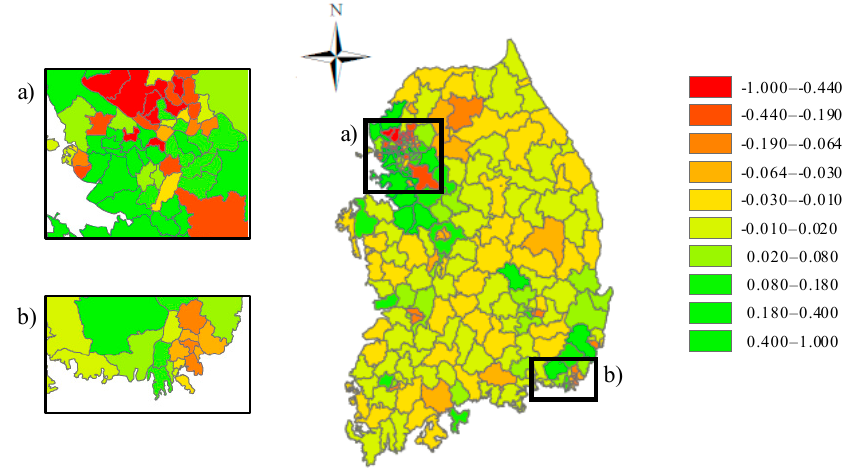
Figure 7. Population attraction force (normalized) of cities and counties in South Korea (illustrated with ArcMap TM 10 [53]): ( a ) capital Seoul and vicinity; and ( b ) metropolitan Busan and vicinity.